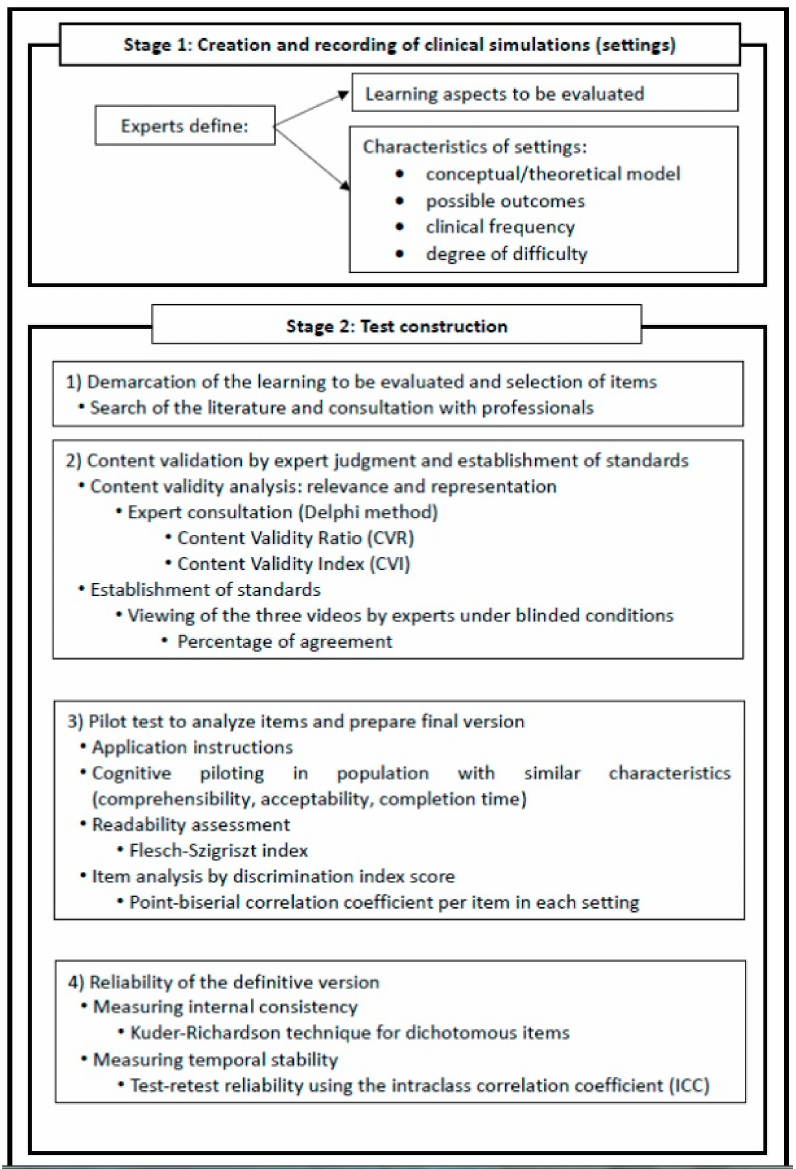
Figure 1. General diagram of the study: process of questionnaire